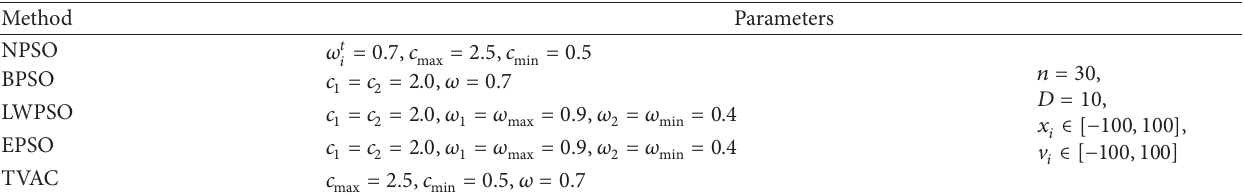
Table 1: Parameters for